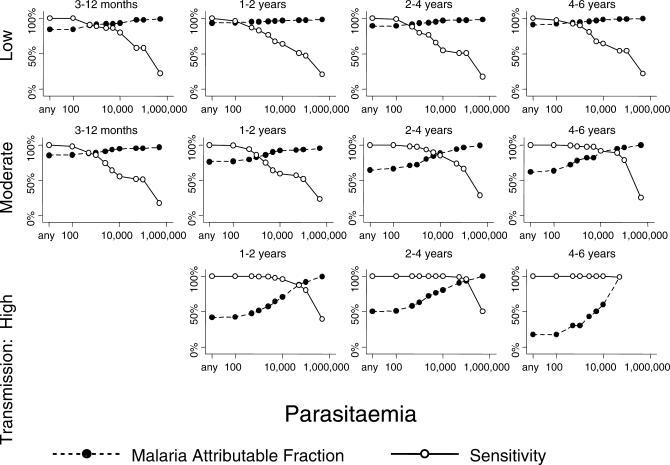
The Attributable Fractions and Sensitivity for Severe MalariaFractions are shown for varying parasite density thresholds according to age group and location. Malaria-attributable fractions are indicated by closed circles, sensitivity by open circles.